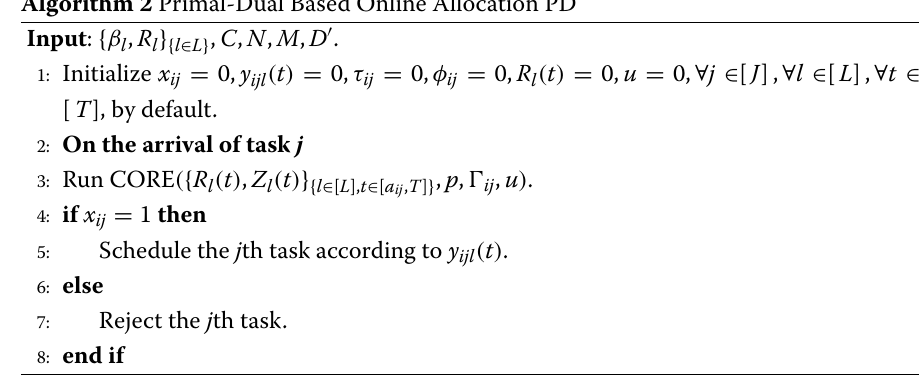
Algorithm 2 Primal-Dual Based Online Allocation